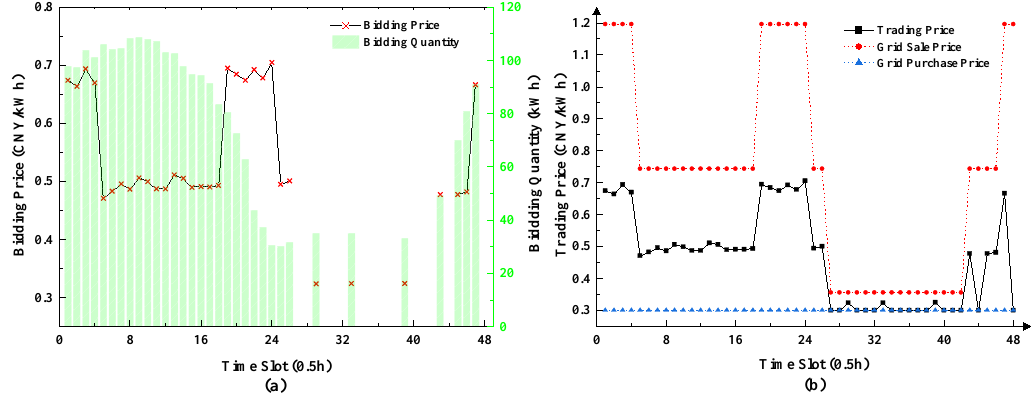
Figure 9. ( a ) Bidding price and quantity of MG 9; ( b ) actual trading price of MG 9. The trading performance of MG 12 is shown in Figure 10, as MG 12 plays different roles in different time slots in a trading cycle. The detailed trading performance of MG 12 between the 9th and 32nd time slot is presented in Figure 10b, in which the buyer and seller intervals are differentiated by two background colors. When the PMWBS is applied, MG 12 has a good performance in both roles: it purchases clean energy from MG 8 and MG 13 at the 12th and 22nd time slot, respectively, to reduce cost; meanwhile, it successfully sells surplus energy to other microgrids to raise its profit. The overall profit of MG 12 is significantly increased from 421.2 CNY/day to 581.0